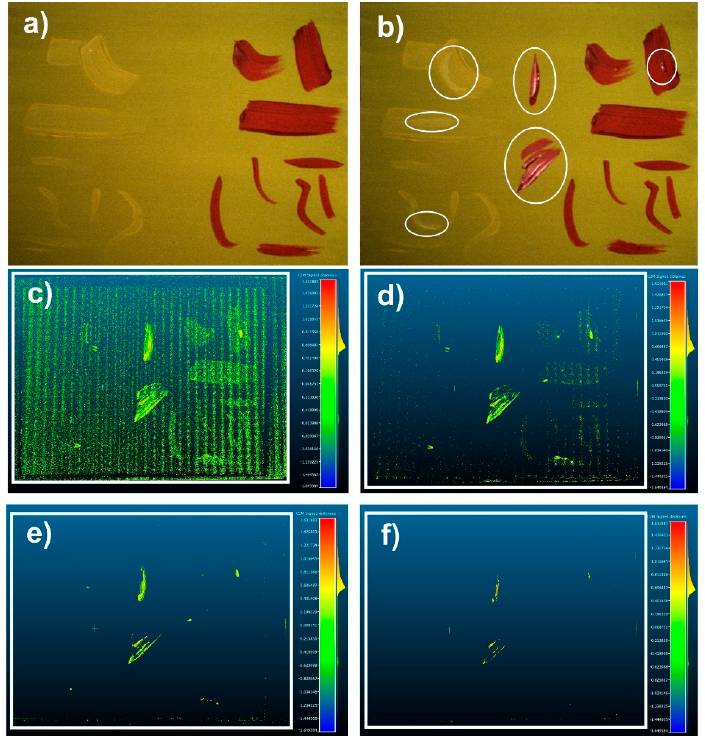
Figure 4. Initial ( a ) and modified ( b ) samples. One can see the new added brushstrokes; ( c – f ) Different horizontal cuts of the painting at different heights: ( c ) 0.05 mm; ( d ) 0.1 mm; ( e ) 0.2; ( f ) 0.5